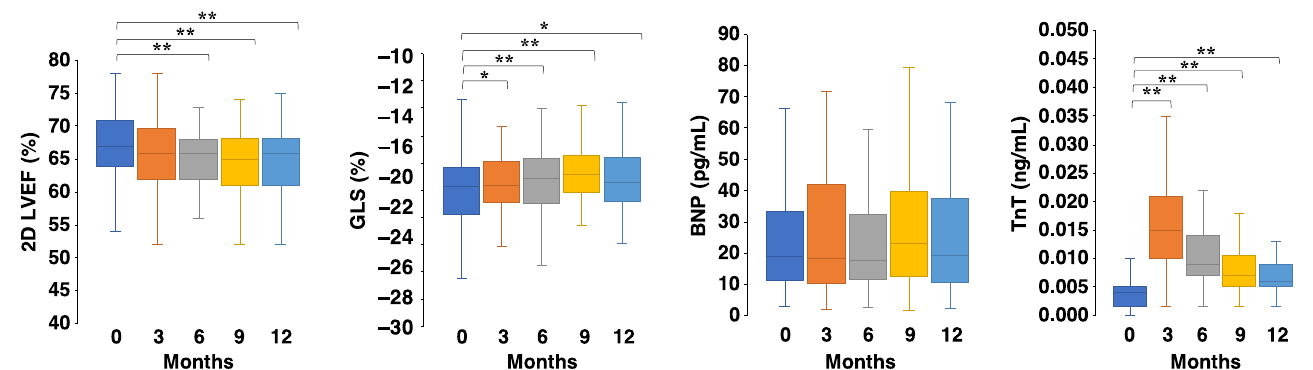
Figure 4. Behavior of echocardiographic parameters and biomarkers. The black line indicates the median; box, 25–75% range; whisker, 10–90% range. 2D: Two-dimensional, BNP: B-type natriuretic peptide, GLS: Global longitudinal strain, LVEF: Left ventricular ejection fraction, TnT: Troponin T. * p < 0.05, ** p < 0.01, Friedman test with Bonferroni post hoc test.